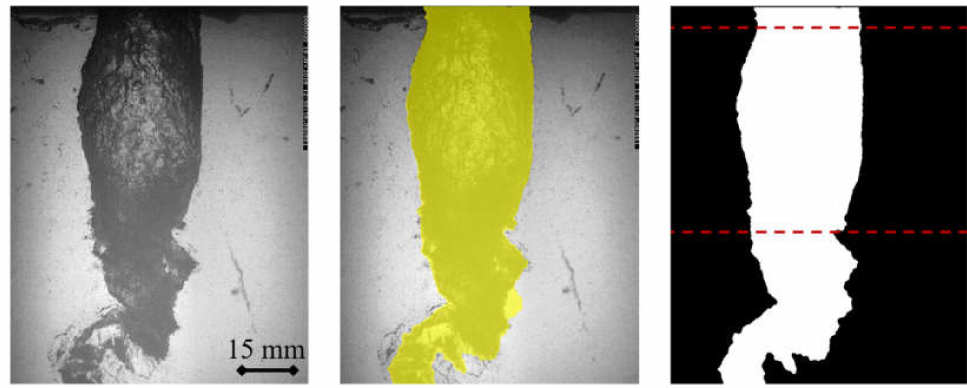
Figure 5. Example of image processing. Raw, masked, and binarized images. Condition 5 ( n = 910 r/min and Q = 0.031 m 3